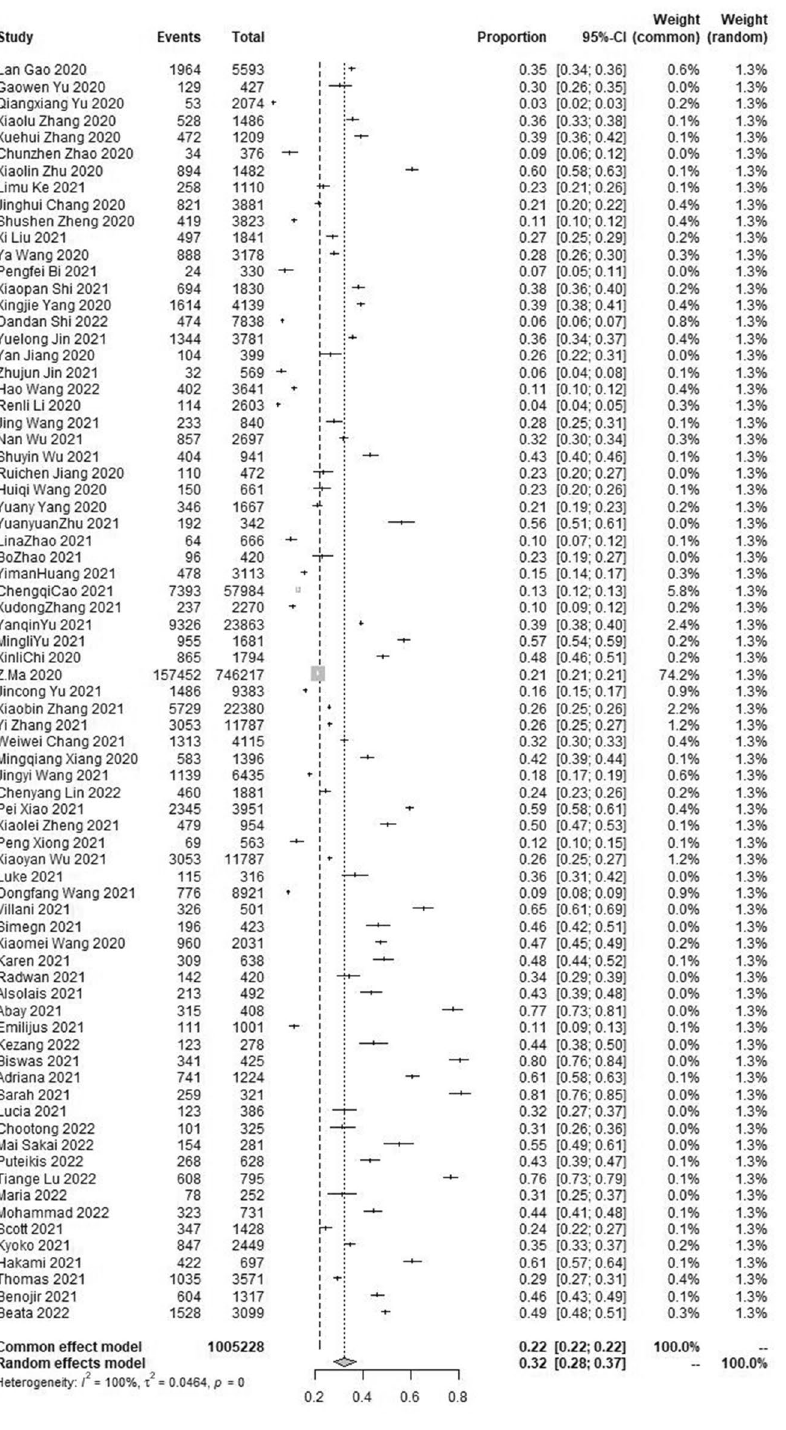
Figure 2. Forest plot of the meta-analysis on prevalence rates of depressive symptoms in the student